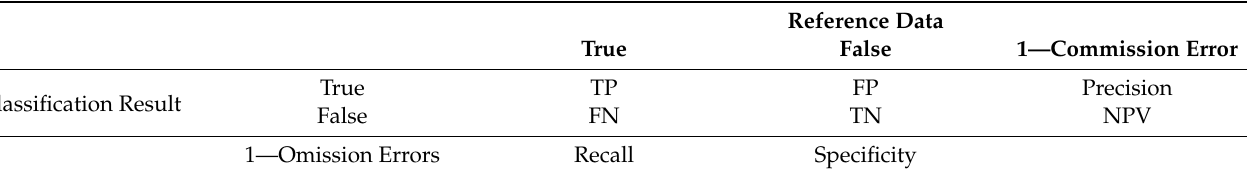
Table 3. Example binary confusion matrix and associated terminology. TP = true positive, FP = false positive, TN = true negative, and FN = false